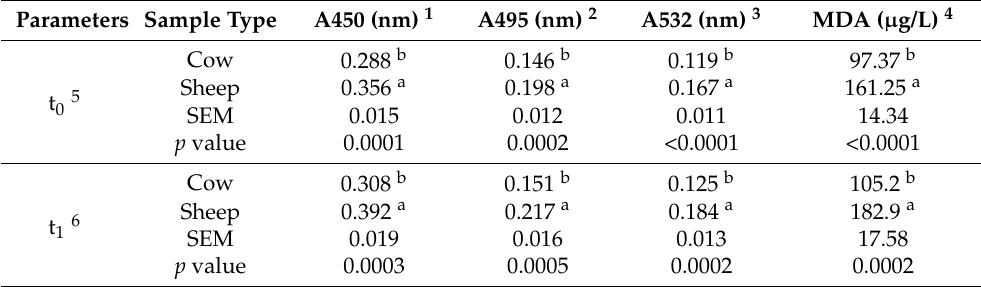
Table 5. Samples absorbances obtained using the optimized TBARS method and MDA concentrations ( n =